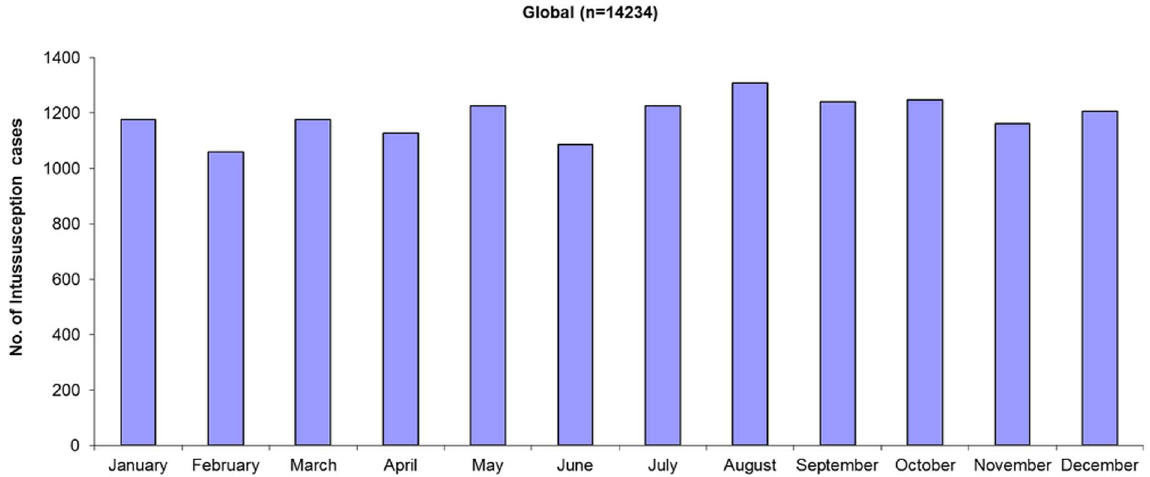
Figure 4. Seasonality of intussusception globally.